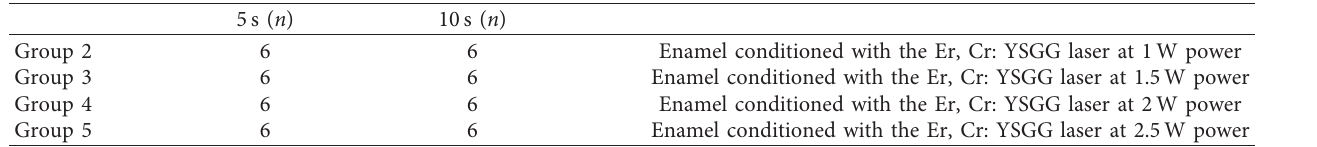
Table 2: Definition of laser groups regarding times.